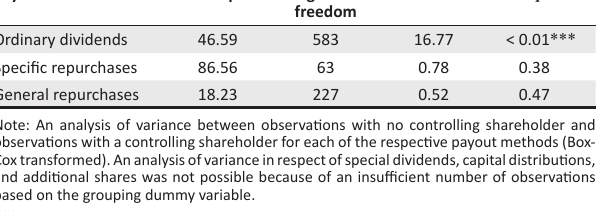
FIGURE 3: Comparison of payout behaviour for low and high ownership concentration. TABLE 3: Analysis of variance of payout methods (Controlling shareholder). Payout